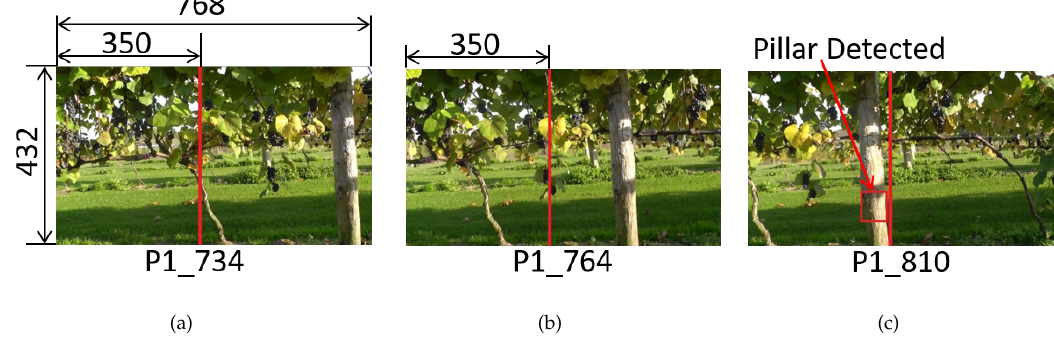
Figure 5. Pillar detection within horizontal threshold of X_RANGE = 350 shown as red line: ( a ) a new pillar appears on the right side of the frame; ( b ) image captured as the robot moves forward, where the pillar is not detected as it is not within X_RANGE; and ( c ) pillar is recognized as it is within